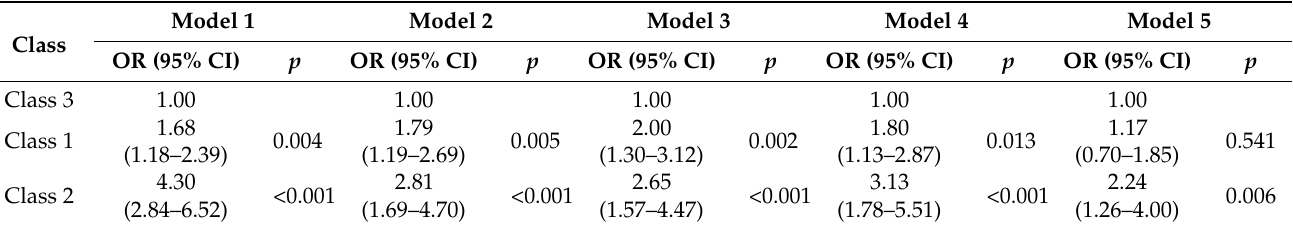
Table 4. Logistic analyses of the association between latent classes of sleep patterns with